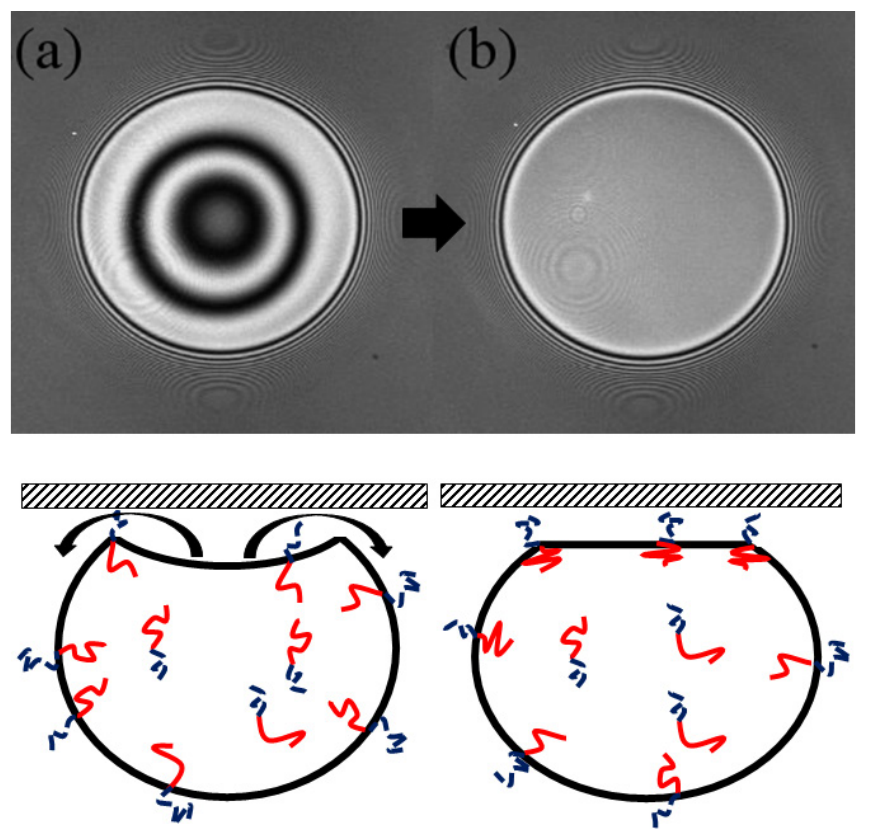
Figure 1. Laser Scanning Confocal Microscopy, (LSCM) images of a PS-PEO covered emulsion droplet in water pressed up against a mica sheet and the corresponding side view schematics. ( a ) Stage 2, where the trapped pocket of water is in the process of draining out. The lower figure shows a cross section through the drop highlighting the buckled region and trapped fluid under the center of the drop. Arrows indicate the direction of flow as the buckled region drains; ( b ) An image of a drop after the drop has reached an equilibrium. At this stage there are no dynamic processes which take place, and the drop lies in intimate contact with the mica.